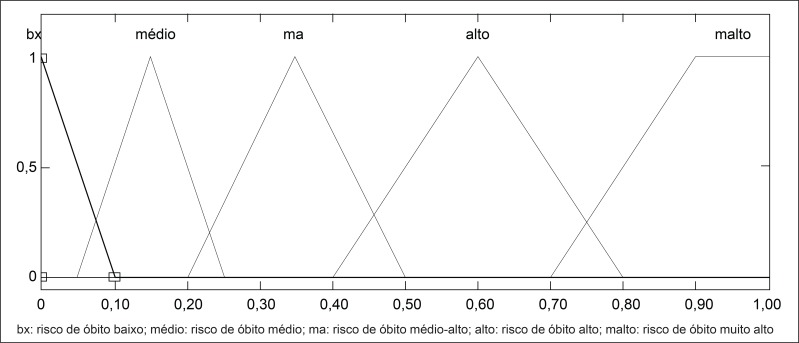
Variável de saída: risco de morte neonatal. Taubaté, 2005-2006